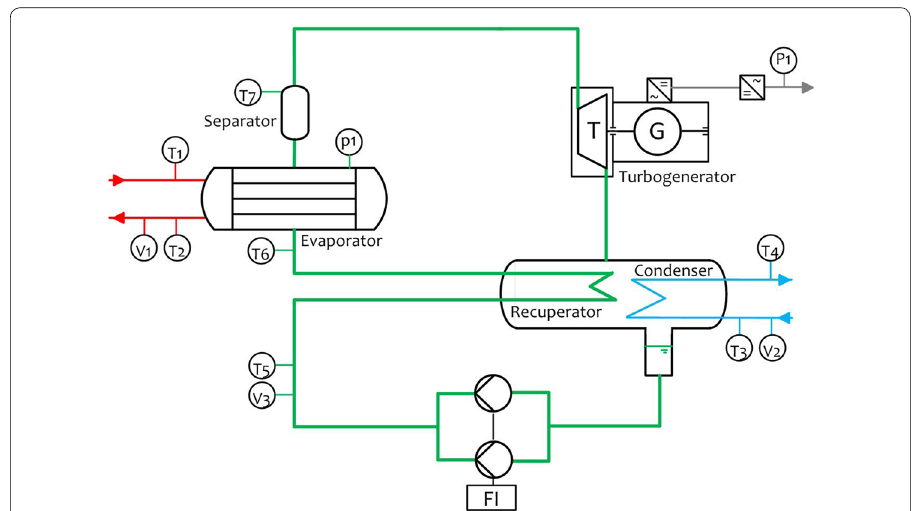
Fig. 11 ORC process diagram showing the used instrumentation